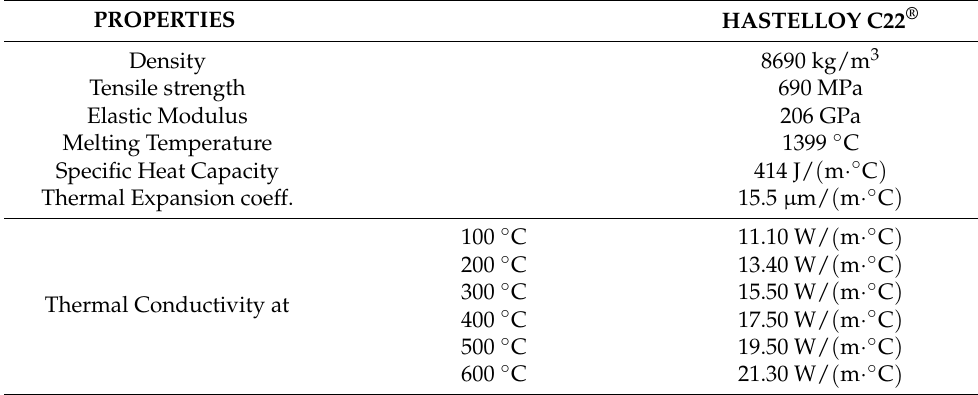
Table A5. Mechanical and thermal properties of the three insulating materials, candidates for components (ref. 08) and (ref. 09). See https://www.corning.com/worldwide/en/products/advanced-optics/product-materials/specialty-glass-and-